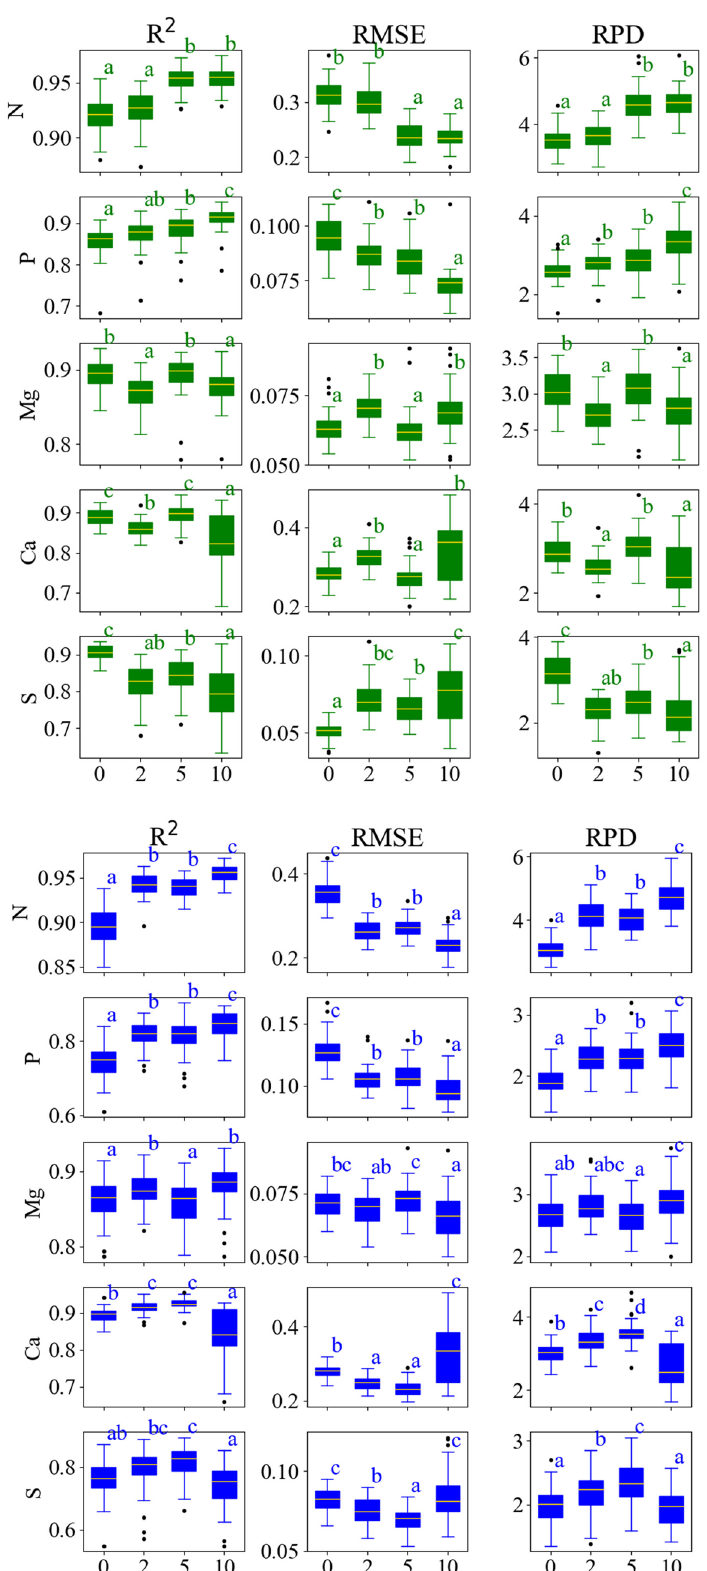
Figure 4. Boxplots of R 2 , root mean square error (RMSE), the ratio of performance to deviation (RPD), and bias for the prediction of 4 properties for each level of fine grinding for ATR (top) and DRIFT (bottom) spectroscopy techniques. Each boxplot is labeled with Tukey’s significance letters ( p < 0.05) for comparison purposes. Fine grinding levels are in